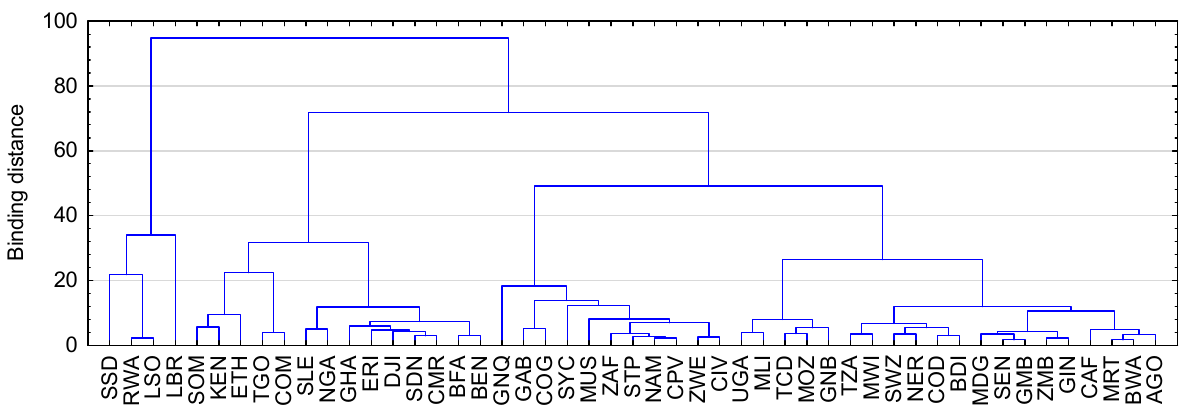
Figure 3. Classification of individual countries in relation to the year-on-year change in the value of the indicators analysed. Source: own study.